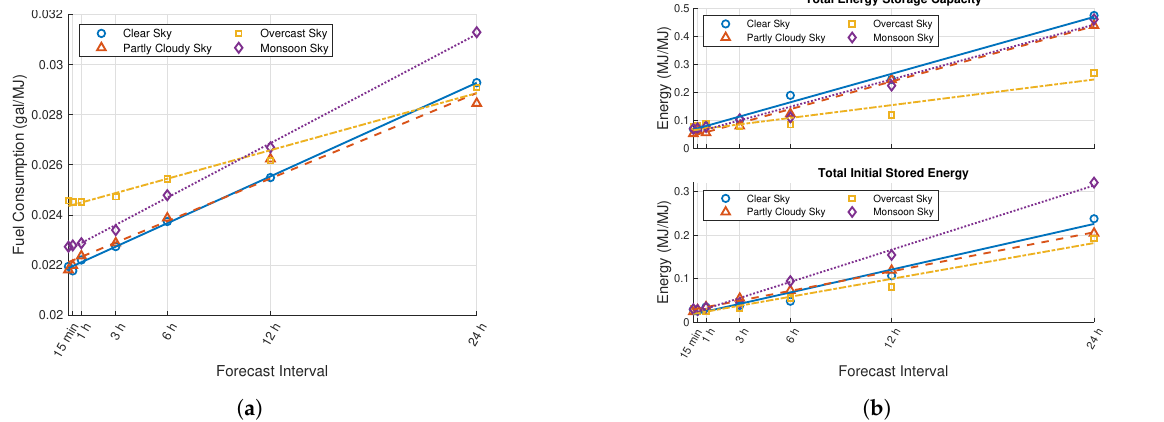
Figure 10. The normalized microgrid performance metrics as a function of forecast interval for each of the four sky conditions. ( a ) Load-normalized fuel consumption versus forecast update period, t u , for all four sky conditions. ( b ) Load-normalized storage capacity and initial storage state versus forecast update period, t u , for all four sky